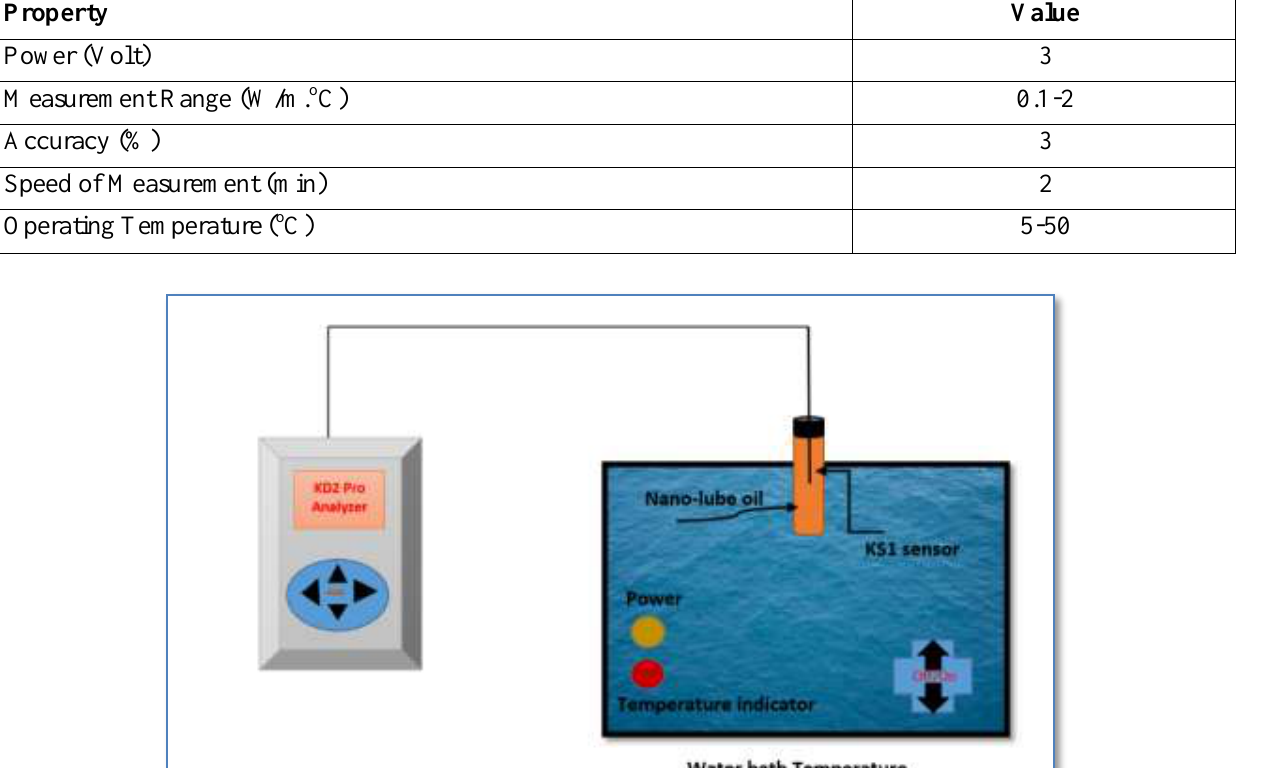
Table 2: Specifications of thermal conductivity measuring system.